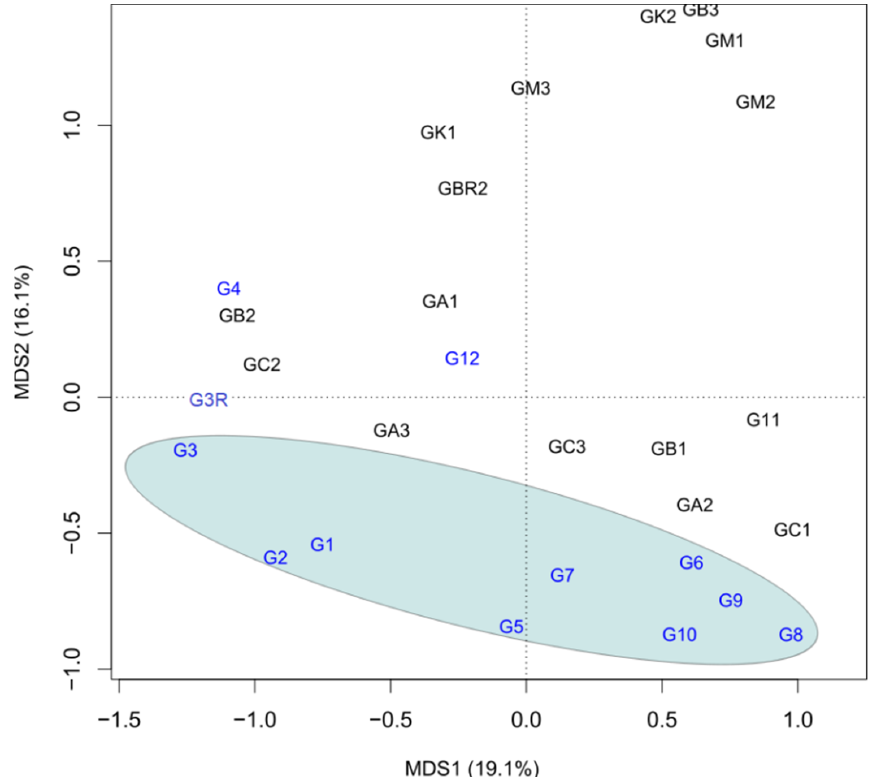
Figure 2. The principal coordinate analysis (PCoA) generated from the sequencing results of the 16S rRNA gene at the genus level. G—midgut samples of individuals from the T0 group (marked in blue); GA, GB, GC, GK, GM—midgut samples of individuals exposed to S. arenarium , S. bicornutum , S. carpocapse , S. kraussei , and S. megidis , respectively (marked in black). The numbers are an integral part of the sample name. All samples are further described in Table 1.